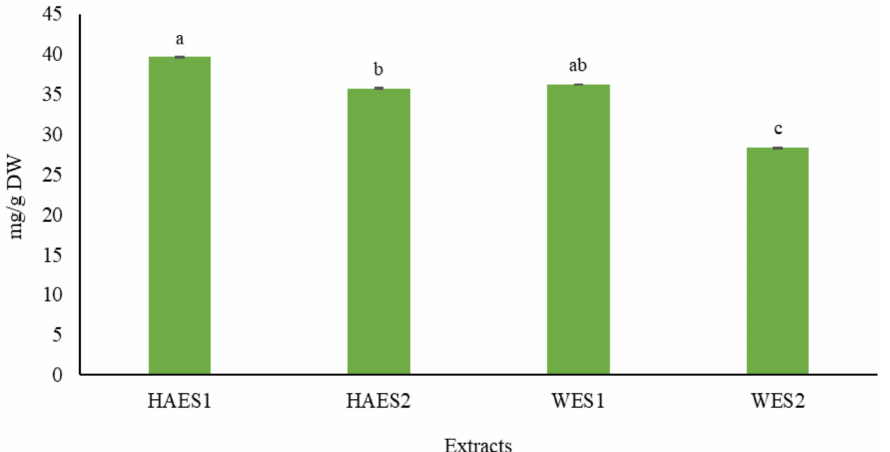
Figure 1. Total phenol content (TPC) (mg/g dry weight) of Scrophularia striata aerial parts extracts